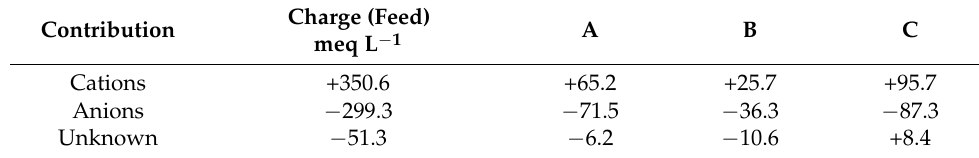
Table 7. Charge balance of the feed and the permeate from Membranes A, B, and C.